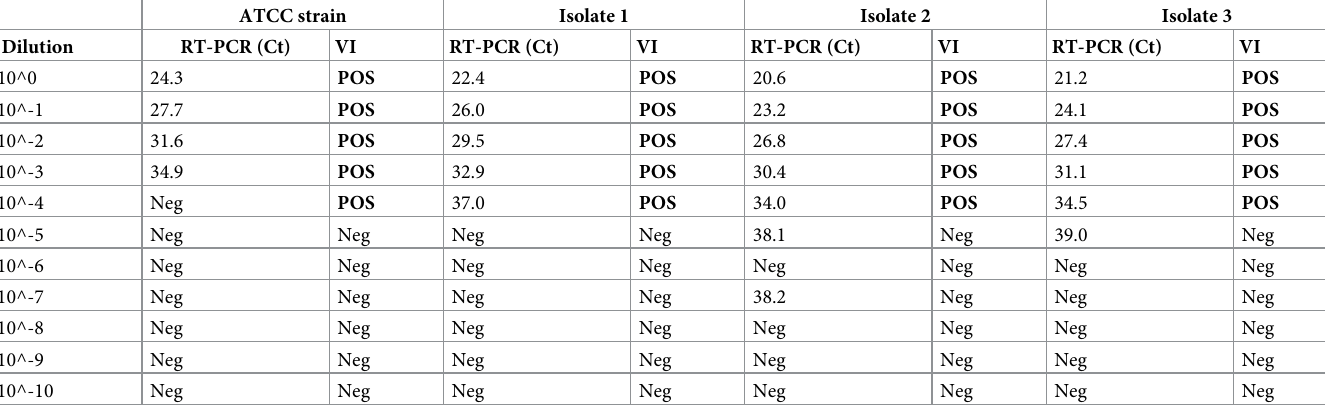
Table 1. Comparison of RT-PCR and virus isolation of commercially acquired and field isolates of CDV.